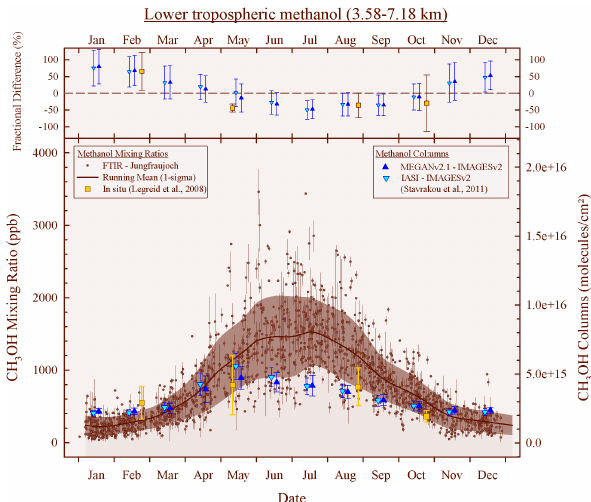
Figure 6. Lower-tropospheric methanol (3.58–7.18km). Dots with vertical lines represent the daily mean lower-tropospheric columns over a 1-year time base and their associated standard deviation. The brown curve corresponds to a running mean fit to all data points, with a 15-day step and a 2-month wide integration time. The area corresponds to the 1 σ standard deviation associated to the running mean curve. Up and down blue triangles are monthly means of the model IMAGESv2 simulations for MEGAN and IASI respec- tively (Stavrakou et al., 2011). Yellow squares are seasonal means of methanol in situ measurements (Legreid et al., 2008). The upper panel shows monthly fractional difference between the FTIR results and IMAGESv2 simulations and seasonal fraction difference with in situ